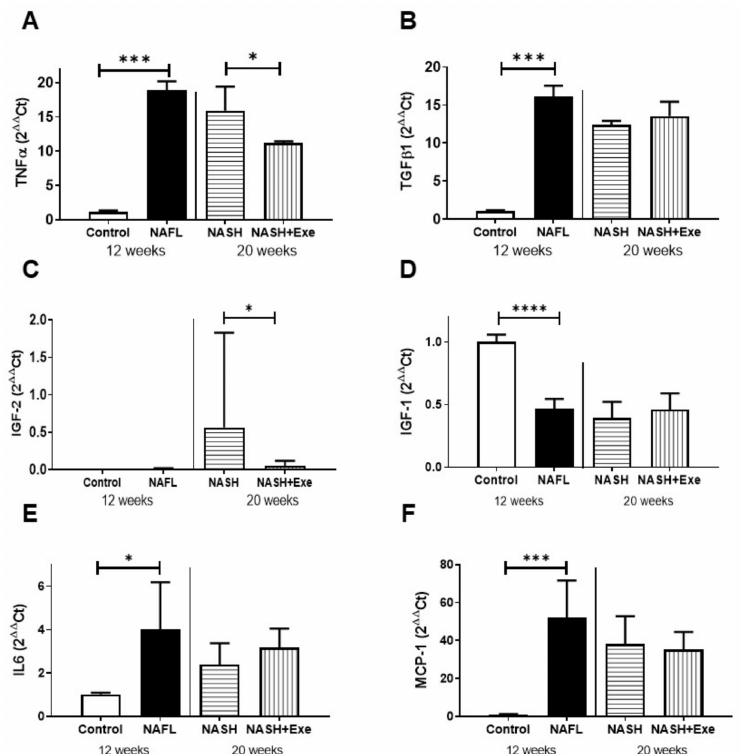
Figure 6. E ff ect of exercise on expression of liver biomarkers. Semi-quantitative PCR analysis of mRNA expression relative to β 2 microglobulin in livers from control, NAFL, NASH, and NASH + EXE groups. ( A ) Tumor necrosis factor α (TNF α ) was increased in NAFL vs. control ( p < 0.001) and decreased in NASH + EXE vs. NASH sedentary ( p = 0.05). ( B ) Transforming growth factor β (TGF β 1) was increased in the NAFL vs. control group ( p < 0.001) but not changed in NASH vs. NASH + EXE. ( C ) Insulin-like growth factor 2 (IGF-2) was increased in the NASH sedentary relative to NASH + EXE. ( D ) IGF-1 was decreased by CD-HFD. ( E ) Interleukin-6 (IL6) increased in NAFL. ( F ) Monocyte chemoattractant protein 1 (MCP-1) increased in NAFL. Groups are described in Figure 1 (unpaired t -test; * p ≤ 0.05; *** p < 0.001; **** p <